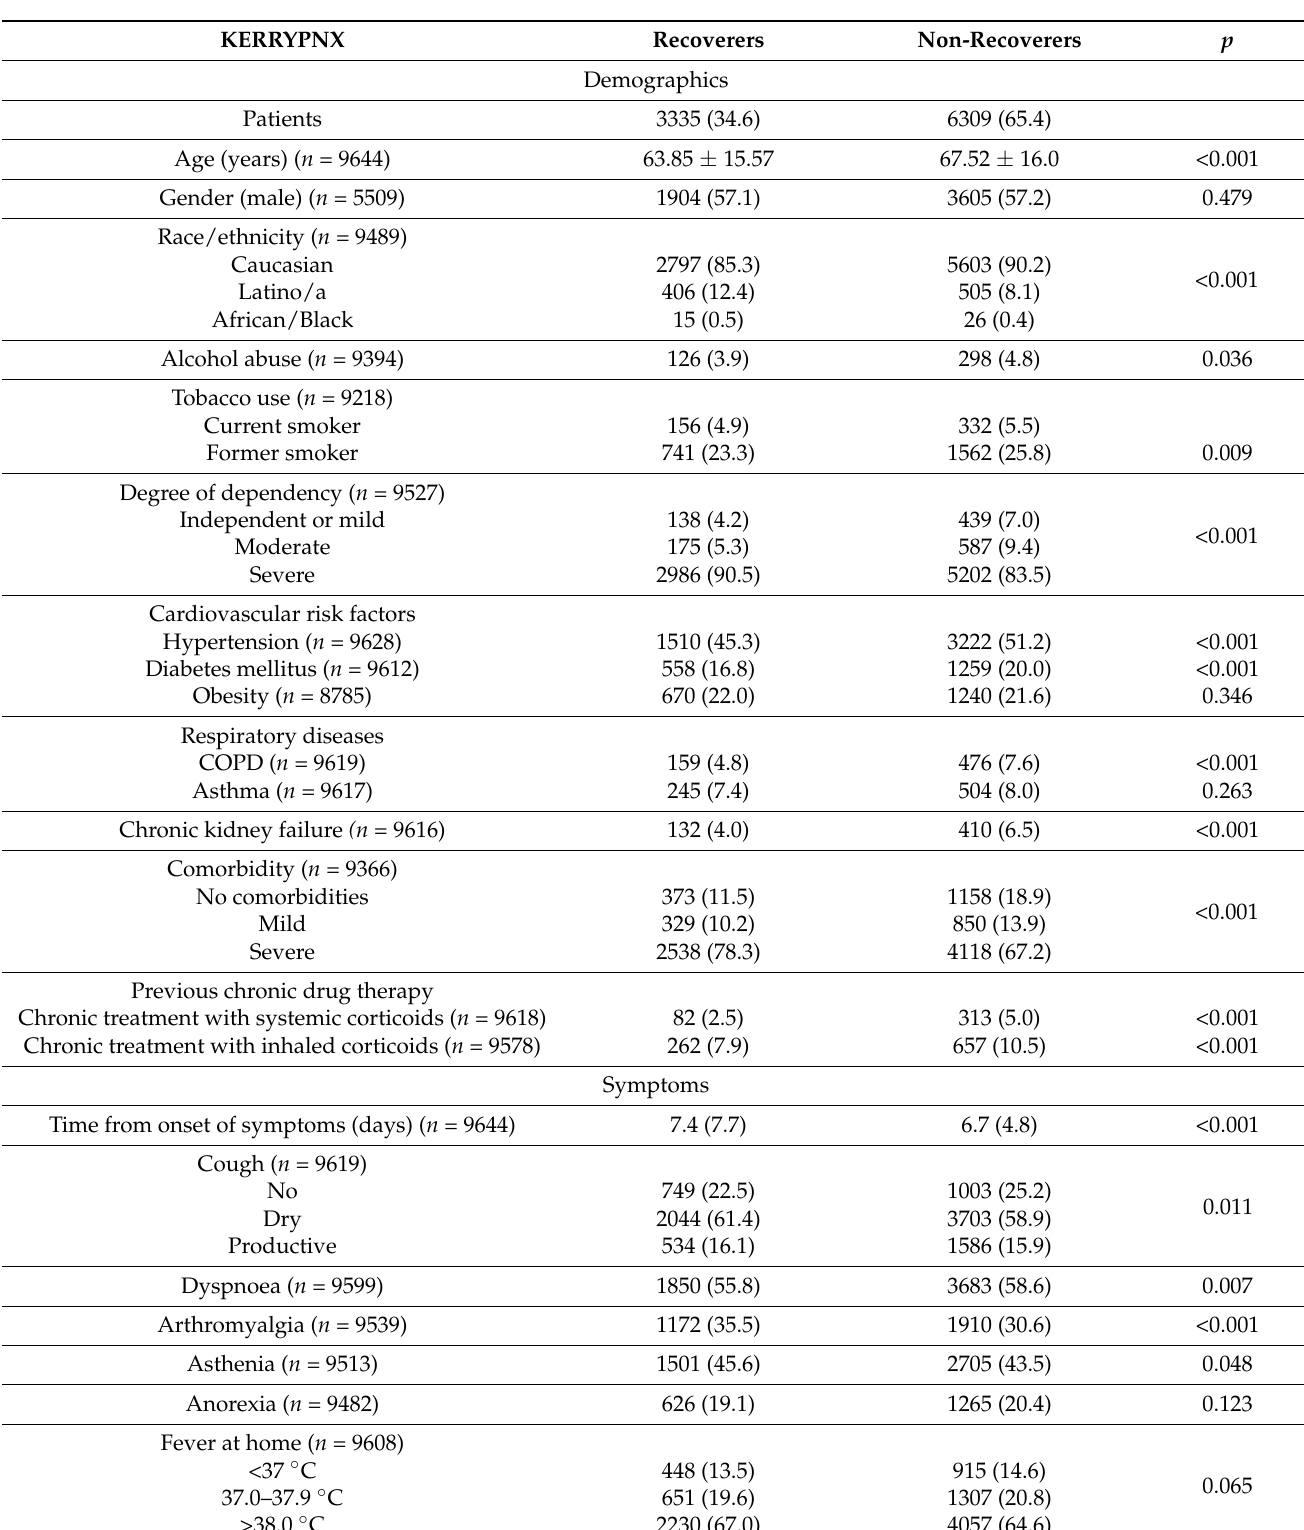
Table 1. Baseline demographic and clinical features upon admission of patients with eosinophil recovery during the course of COVID-19 (Recoverers) and those who did not